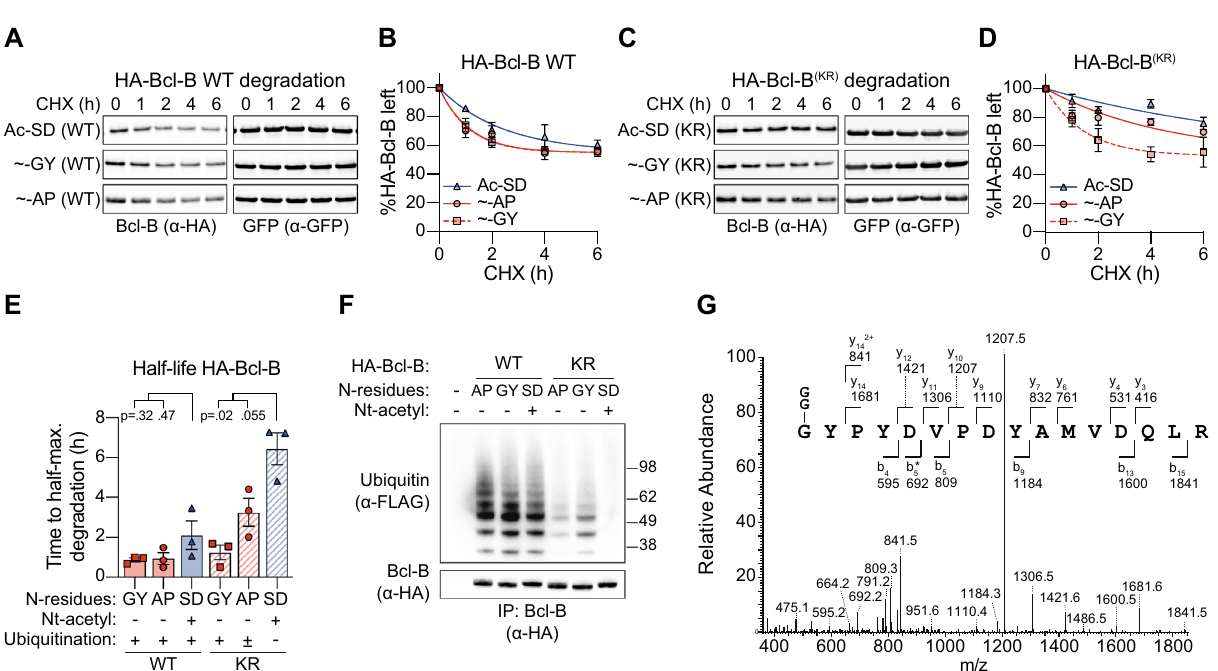
Figure 3. Ubiquitination, rather than Nt-acetylation, determines Bcl-B protein stability. ( A , B ) HEK 293T cells were transfected to express GFP as a reference protein, together with HA-Bcl-B variants carrying indicated N-terminal dipeptide sequences (”Ac-” = Nt-acetylated, “ ~ ” = Nt-acetyl-free). Cells were cultured in presence of CHX (50 μg/ml) for the indicated time periods, followed by immunoblot analysis with antibodies to the HA tag and to GFP. HA-Bcl-B signals were quantified and corrected for GFP signal intensity, and the resulting value at the 0 h time point was set to 100%. Data points were connected by a one-phase decay curve fit. Panel A shows a representative Western blot image, panel B shows the quantification (n = 3; mean ± SEM). ( C , D ) As in A and B, but for a lysineless (KR) HA-Bcl-B mutant (n = 3; mean ± SEM). ( E ) Based on the data in panels B and D, the half-lives of the indicated HA-Bcl-B variants were determined (n = 3; mean ± SEM, One-way ANOVA, post hoc Dunnett’s). ( F ) HEK 293T cells were transfected to express indicated HA-Bcl-B variants and FLAG-tagged ubiquitin, followed by lysis under denaturing conditions. Next, HA-Bcl-B was immunoprecipitated and the precipitates were analyzed by immunoblotting. A representative image of two independent biological replicates is shown. ( G ) [GY]HA-Bcl-B(KR) was precipitated from HEK 293T lysates, trypsin-digested and analyzed by MS. Shown is the tandem mass spectrum of the N-terminal tryptic peptide, containing a di-glycine (GG) modified N-terminus. 2 + = doubly charged, * = minus H 2